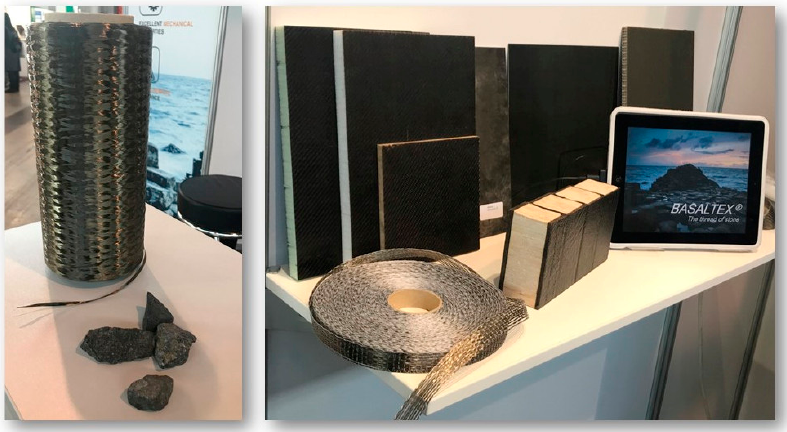
Figure 1. Various basalt products (fibers, rocks, laminates) from Basaltex displayed at Composites Europe, Stuttgart, Germany 2019 (photo by authors at the event).